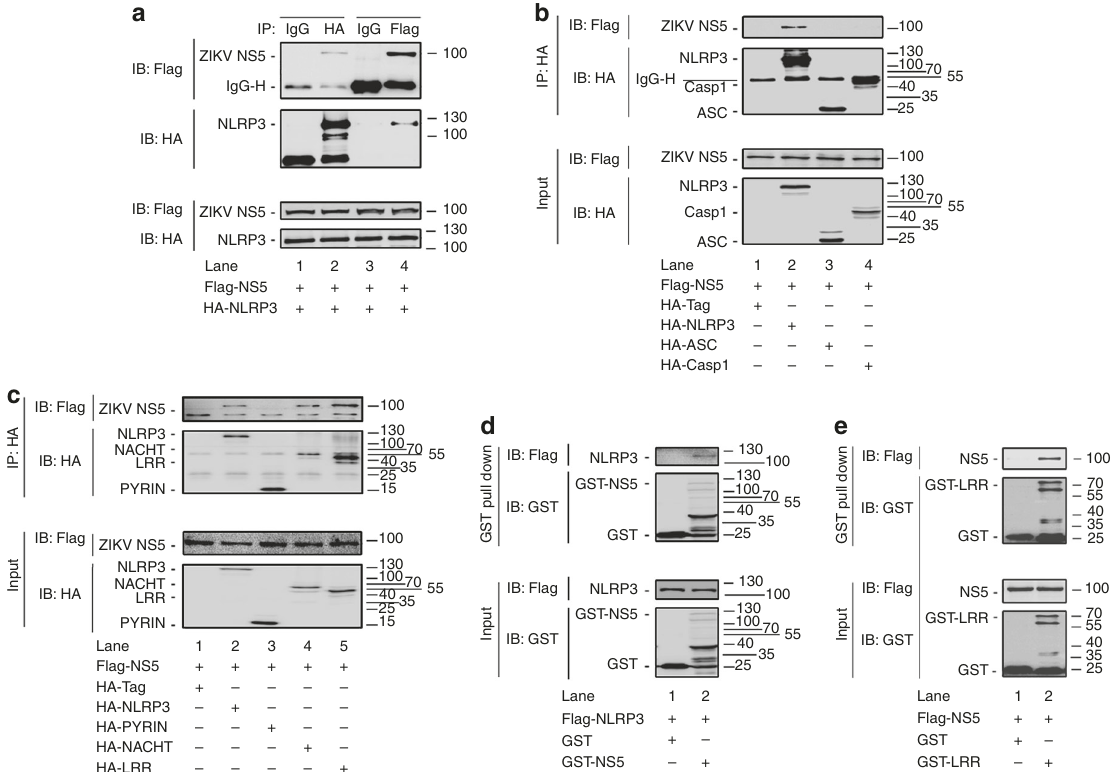
Fig. 5 Interaction of ZIKV NS5 with NLRP3 protein. a – c HEK293T cells were co-transfected with pFlag-NS5 and pHA-NLRP3 ( a ); co-transfected with pFlag- NS5 and pHA-NLRP3, pHA-ASC, or pHA-Casp-1 ( b ); or co-transfected with pFlag-NS5 and pHA-NLRP3, pHA-PYRIN, pHA-NACHT, or pHA-LRR ( c ). Cell lysates were prepared and subjected to IP using a hepatitis C virus IgG, anti-HA, or anti-Flag antibody and analyzed by immunoblotting using an anti-HA or anti-Flag antibody (top) or subjected directly to western blot using an anti-Flag or anti-HA antibody (as input) (bottom). d , e HEK293T cells were transfected with pFlag-NLRP3 and incubated with 10 μ g GST or GST-NS5 ( d ) or transfected with pFlag-NS5 and incubated with 10 μ g GST or GST-LRR ( e ). Cell extracts were incubated with glutathione-Sepharose beads. Mixtures were analyzed by immunoblotting using an anti-Flag or anti-GST antibody (top). Cell lysates were analyzed by immunoblotting using an anti-Flag or anti-GST antibody (as input)